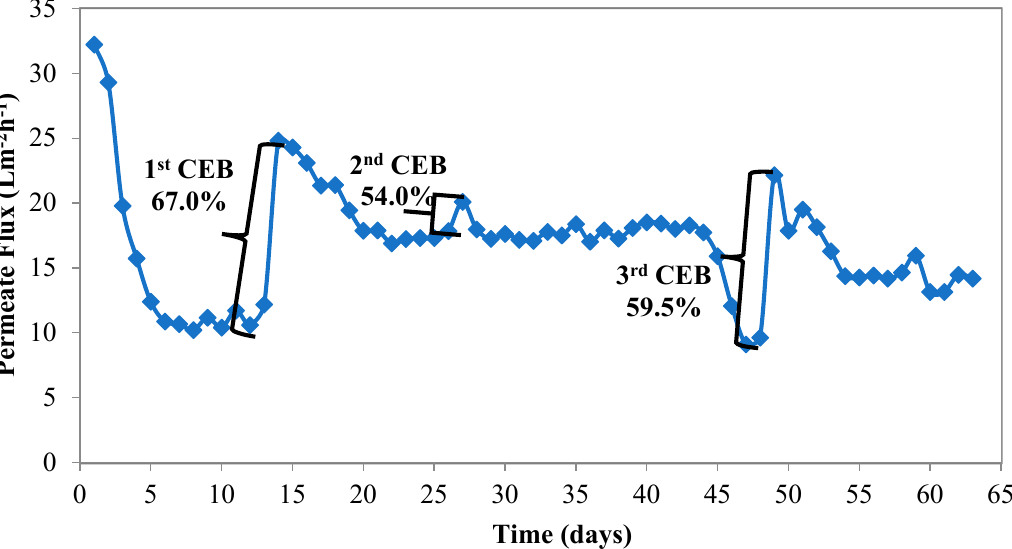
Figure 3. Temperature corrected fl ux versus time plot obtained at high antiscalant concentration (40 mg/L), AS-1 and high MLSS (17–21 g/L). MLSS: mixed liquor suspended solid.